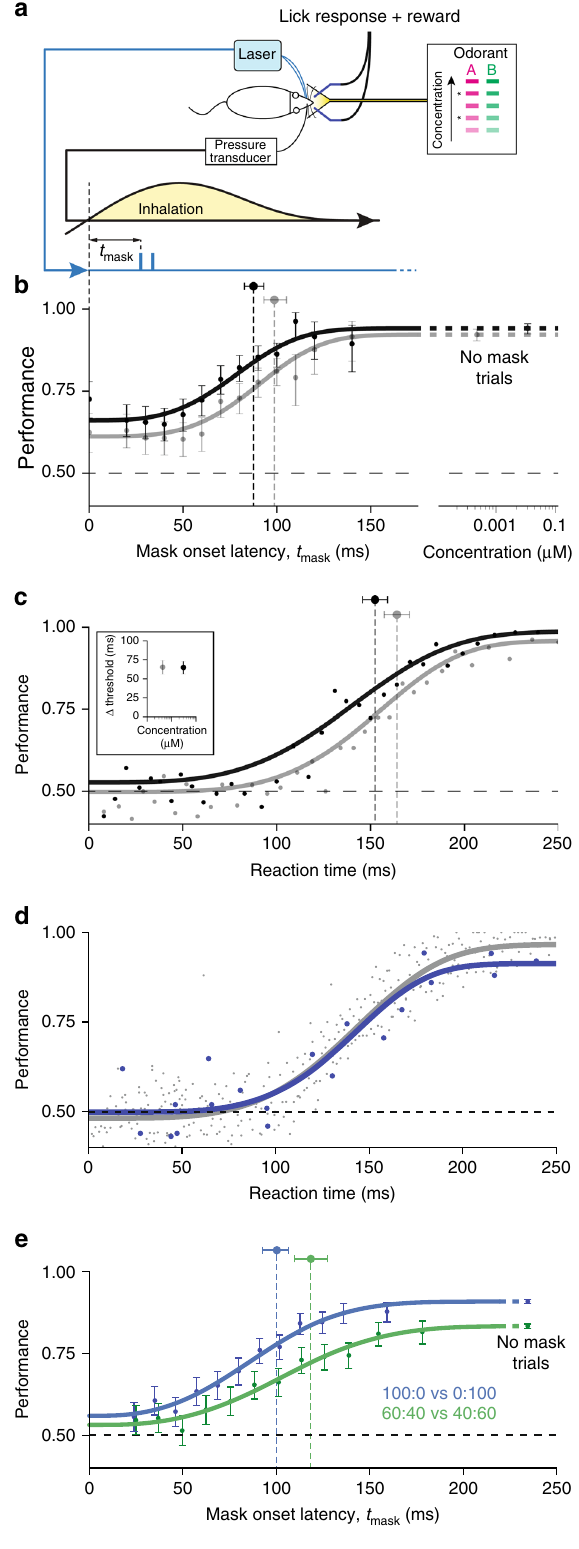
Fig. 3 Optogenetic masking behavioral paradigm. a Behavioral task schematic: Mice were trained to respond to 2 odors "A" and "B" at 5 different concentrations to lick left or right water spout. Mask timed to the onset of the fi rst inhalation after odor delivery was presented during subset of trials for two concentrations (asterisks). b Discrimination performance vs. mask latency for odors (2-hydroxyacetophenone and eugenol) at two concentrations. Mask stimulus presentation was initiated on the fi rst inhalation of odorant and after the mask onset latency, t mask , had elapsed. High concentration annotated in black markers, low concentration in grey. Error bars indicate 95% con fi dence interval estimates. Weibull fi t to the data indicated with thick lines. Markers above performance curves indicate Weibull threshold latency values for each fi t with 95% con fi dence interval estimates. c Mouse reaction time vs. performance in unmasked stimuli of two concentrations (as above). Dots indicate the data binned into bins of 125 trials. Lines indicate Weibull fi t. Inset: difference between mask and reaction time threshold latencies. d Mouse reaction time vs. performance for unmasked trials (gray) compared with late masked trials with t mask > = 100 ms (blue) for the same data set. Points represent bins of 50 trials each. e Performance vs. mask latency for discrimination of pure (blue) carvone enantiomers vs. mixtures made with those odorants